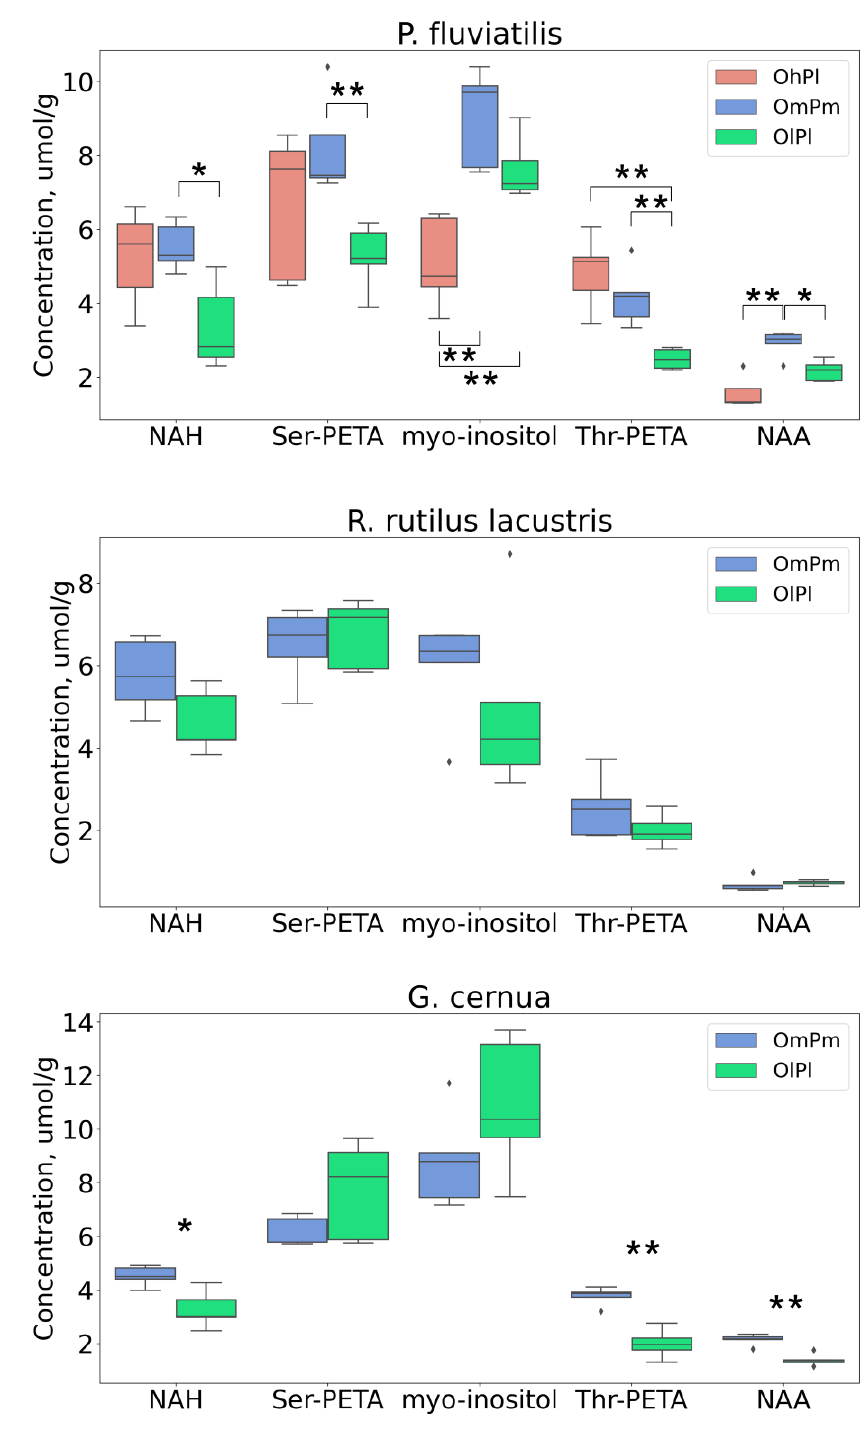
Figure 2. Boxplots for concentrations (in µ moles per gram of wet tissue) of five major osmolytes—NAH, ser-PETA, myo -inositol, thr-PETA, and NAA—in lenses of P. fluviatilis (upper graph), R. rutilus lacustris (middle graphs), and G. cernua (lower graph) from the Nigiya River (green, OlPl), Lake Borovoye (red, OhPl), and the Ob Reservoir (blue, OmPm). One star * indicate statistically significant difference between groups with p -value < 0.05, two stars ** p < 0.01. Rhombs indicate outliers. The level of the antioxidant OSH was previously found to drop significantly during the winter: in the lenses of R. rutilus lacustris and pike-perch ( Sander lucioperca ), its concen-